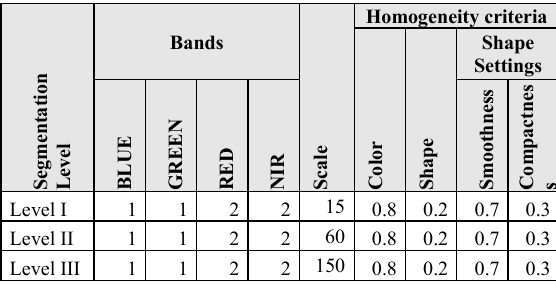
Table 1. Parameters for the segmentation of the Ikonos data The segmentations were based on higher color factor (80%) than the shape factor (20%). The scale parameter is the limit for the maximum heterogeneity allowed to the obtained image objects.